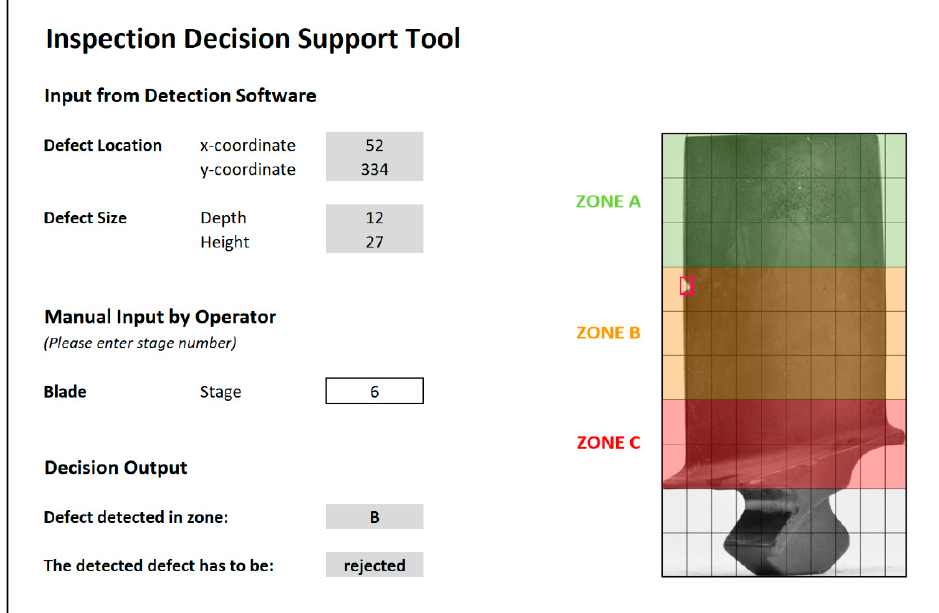
Figure 12. User interface of decision support tool (DST).